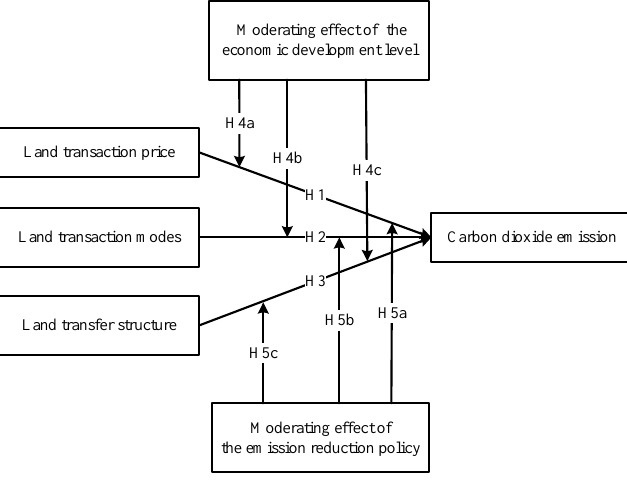
Figure 1. Research framework of this paper.